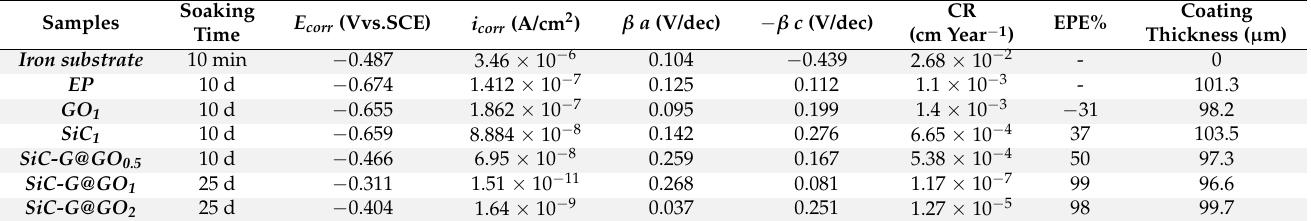
Table 4. The electrochemical corrosion parameters derived from the potentiodynamic polariza- tion